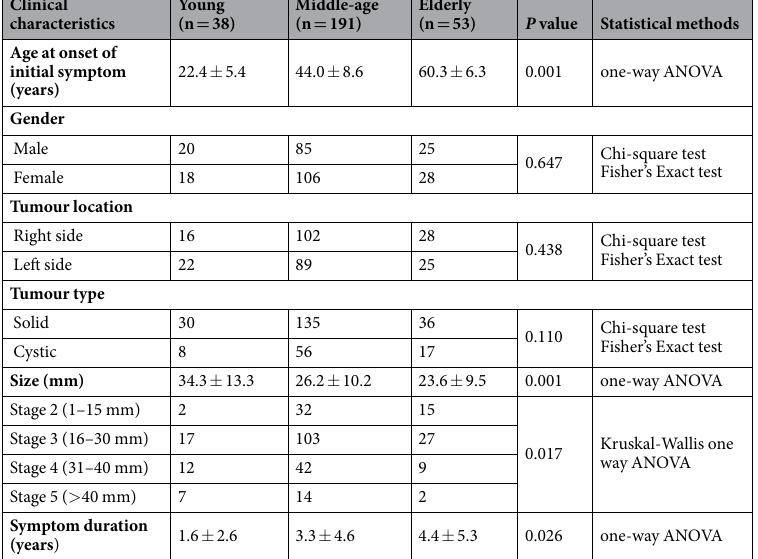
Table 1. Comparisons of clinical characteristics of sporadic VSs in different age groups.